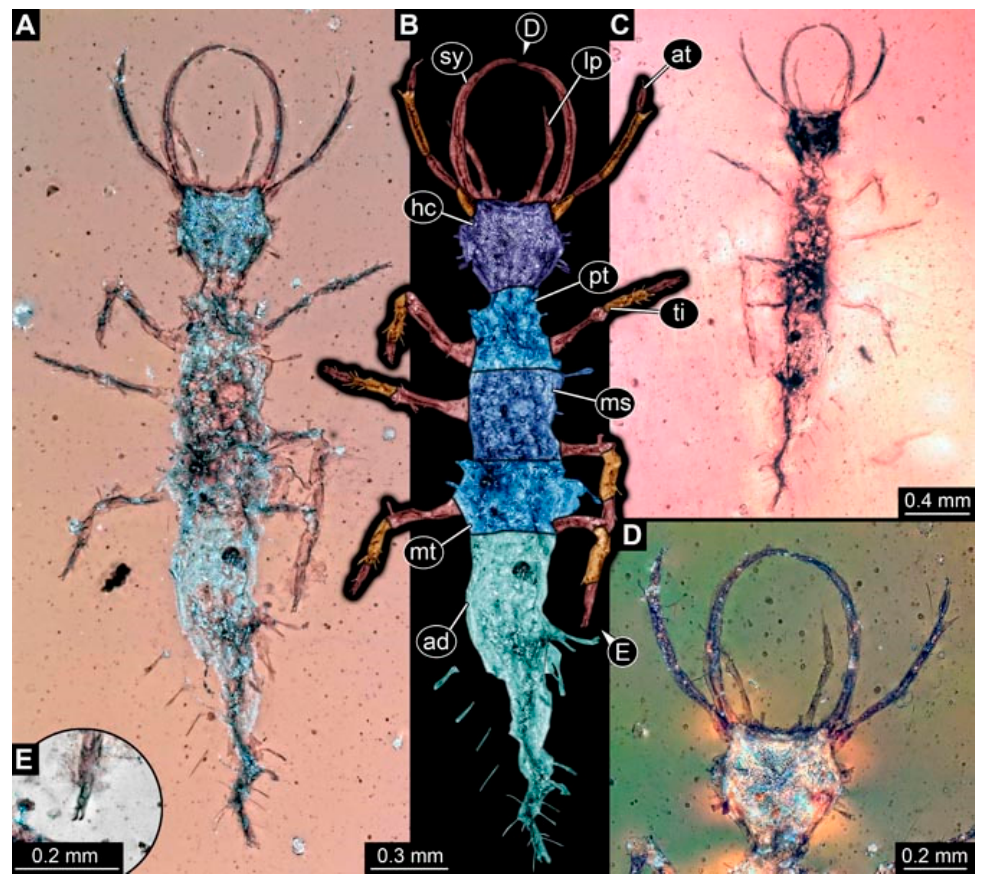
Figure 34. Specimen 4859 (PED 0952); Myanmar amber. ( A ) Dorsal view. ( B ) Dorsal view, colour- marked. ( C ) Ventral view. ( D ) Close-up of head capsule in dorsal view. ( E ) Close-up of distal end of trunk appendage. Abbreviations: ad = abdomen; at = antenna hc = head capsule; lp = labial palp; ms = mesothorax; mt = metathorax; pt = prothorax; sy = stylet; ti = tibia.